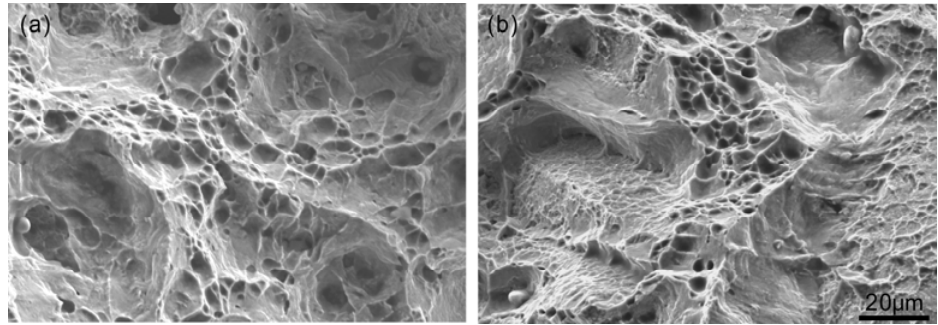
Figure 6. Fracture surface of specimens with a grain size of 51 μ m: ( a ) without precipitates and ( b ) with precipitates.